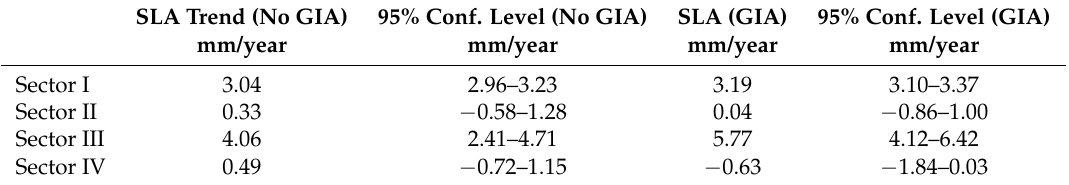
Table 3. SLA trend for each sector and the associated uncertainty. The SLA trend is given with and without GIA correction and the uncertainty is given by a 95% confidence level.